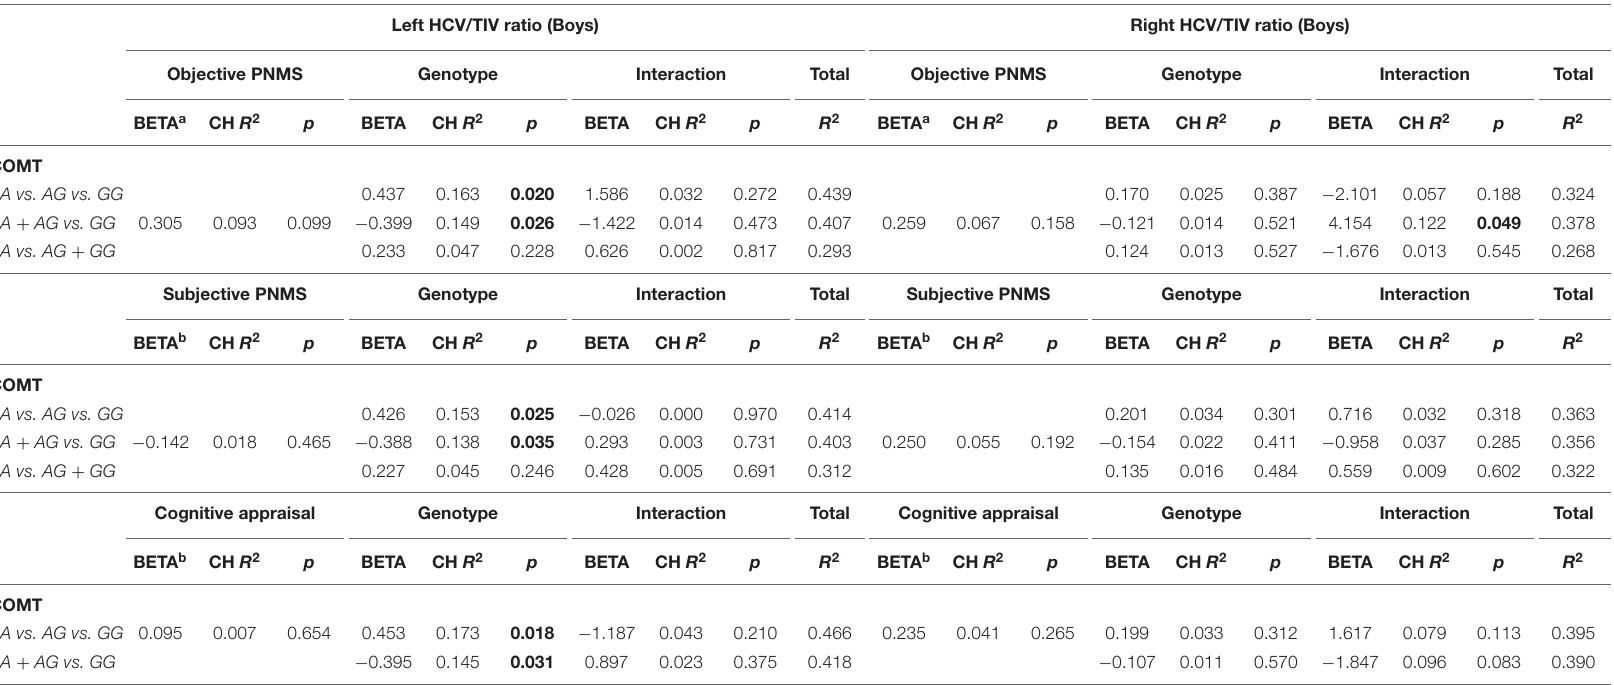
TABLE 5 | Effect of PNMS, genotype and gene-by-environment interaction on HCV/TIV volume in boys, controlling for maternal alcohol consumption during pregnancy with left and right HCV/TIV